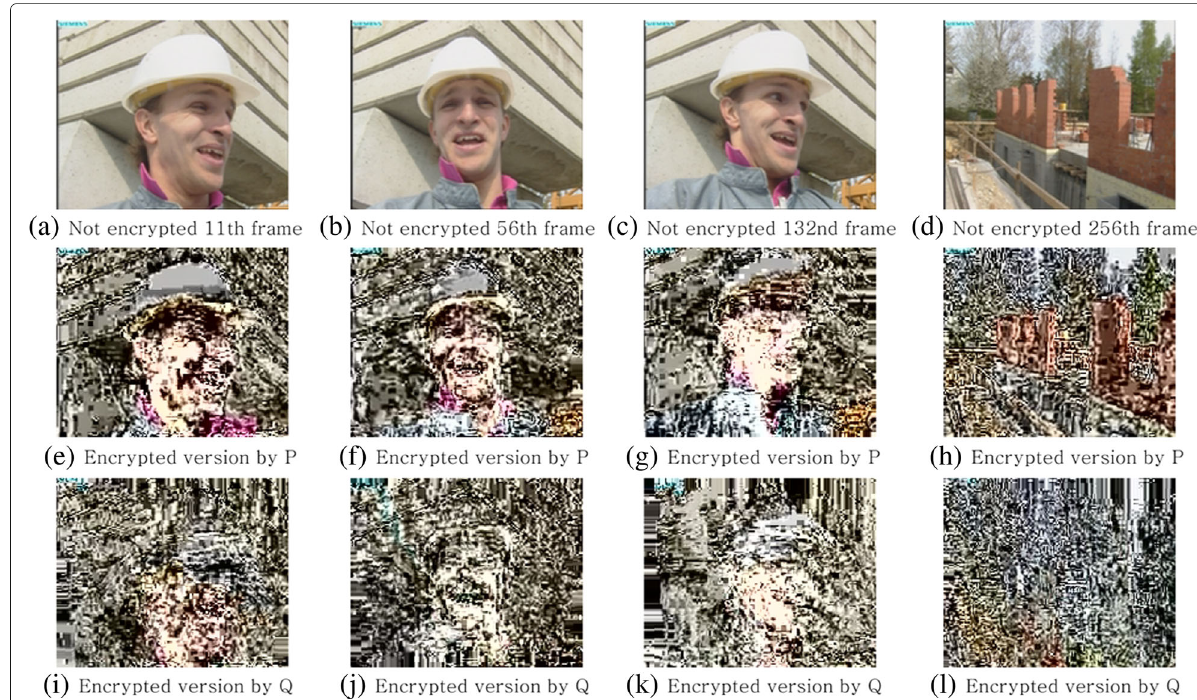
Fig. 6 a – l Sample frames of original and two encrypted videos by using different encryption techniques in scenario Extended-1. These figures show sample frames (11 st , 58 th , 132 nd , and 256 th ) of original Foreman video and its encrypted versions using two JVCE schemes P and Q. P and Q differ only in terms of how they protect the temporal information of the video such as the motion vector. P and Q result in visually different encrypted videos. Regarding Table 5 together, Fig. 6 aims to present that the STVSM appropriately captures the difference of the protection on the temporal information in perceptual manner since it considers both the spatial and temporal information as compared to other metrics